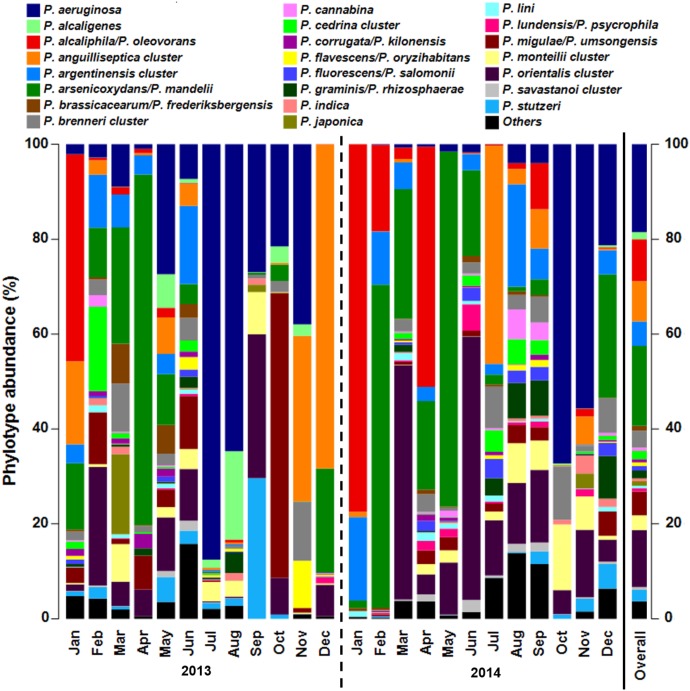
Pseudomonas community composition of cooling tower water samples assessed by genus-specific 16S rRNA gene amplicon sequencing with Illumina MiSeq. Data presented as bar chart showing relative abundance of phylotypes (%). Phylotypes can correspond to species or a cluster of species according to amplified fragment resolution. The species present in each cluster are described in Supplementary Figure 1. Bar chart of data analyzed according to Pseudomonas phylogenetic species groups is shown in Supplementary Figure 6. Samples collected monthly in 2013 and 2014 are separated by year with a dashed line. Bar designated as Overall presents mean relative abundance of Pseudomonas phylotypes for all samples studied. Jan, January; Feb, February; Mar, March; Apr, April; Jun, June; Jul, July; Oct, October; Nov, November; Dec, December.